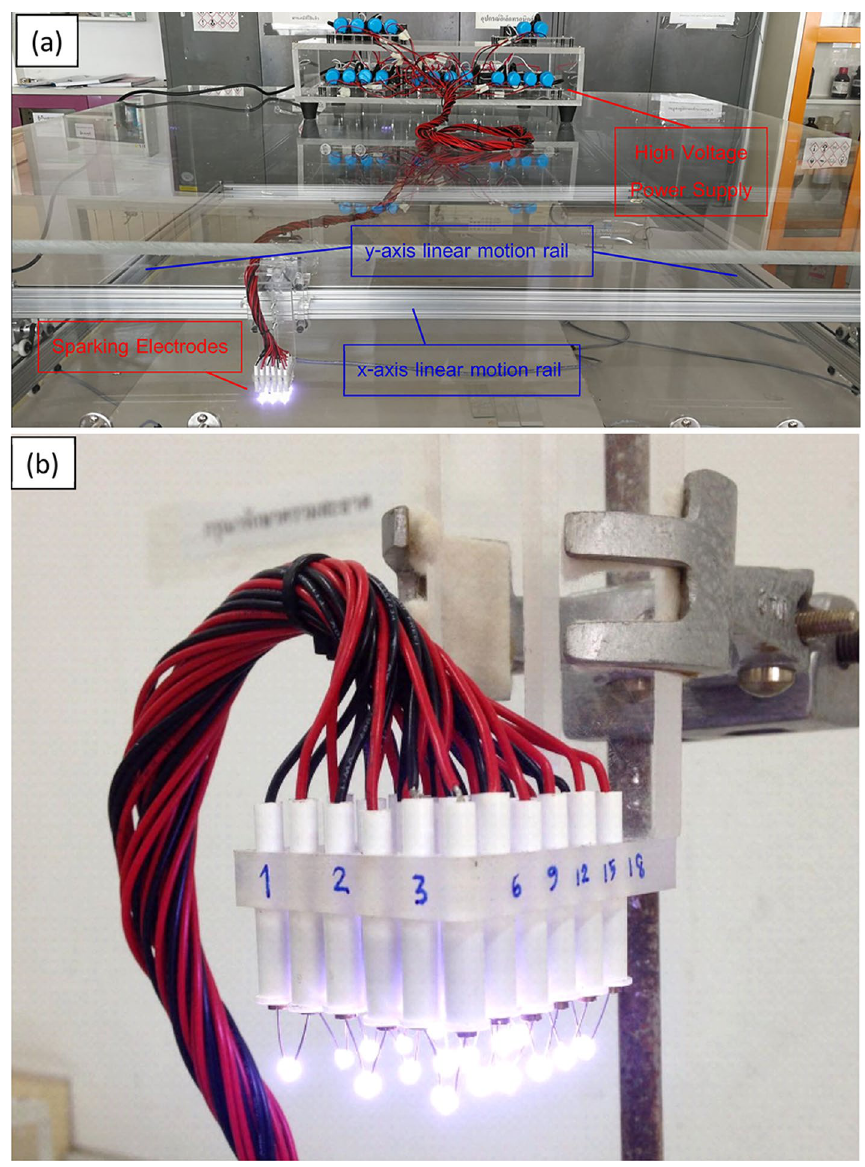
Figure 1. ( a ) Sparking process coating equipment consist of high voltage power supply, x–y axis motion real and sparking electrode ( b ) 18 pairs of Sparking